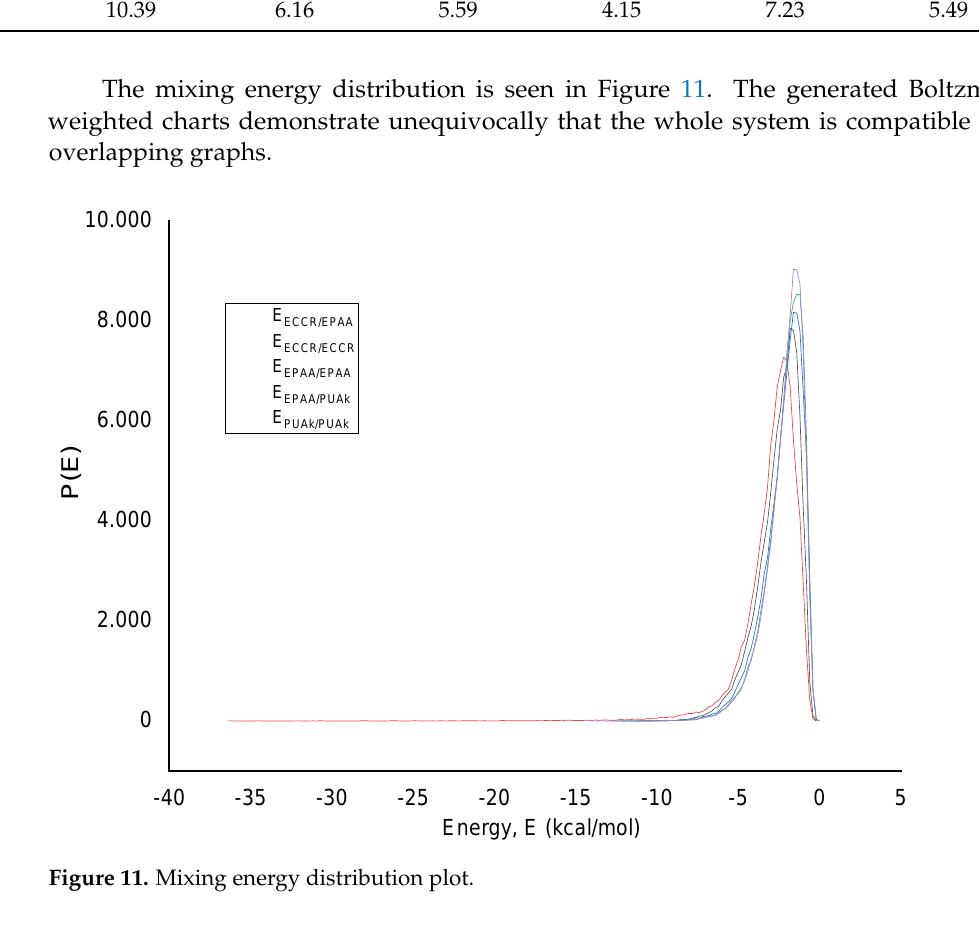
Figure 11. Mixing energy distribution plot. Table 8. Blend of the interacting systems: energies are in kcal mol −1.